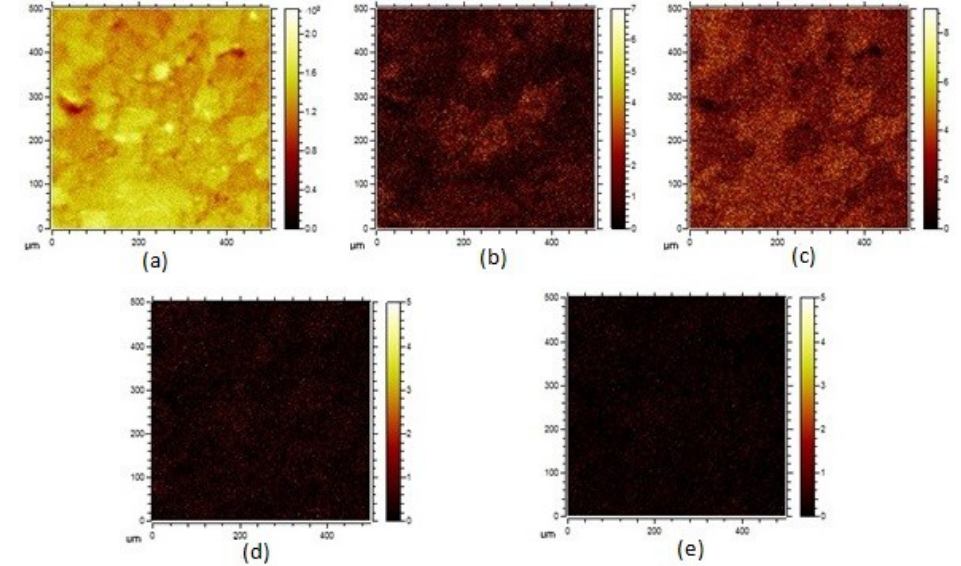
Figure 6. Two-dimensional distributions of ions on the dolomite surface (500 × 500 µm 2 ) treated with H 2 SO 4 (1 × 10 −3 mol/L): ( a ) overlap, ( b ) SO 4− , ( c ) CO 3− , ( d ) CaO − , and ( e ) MgO − .